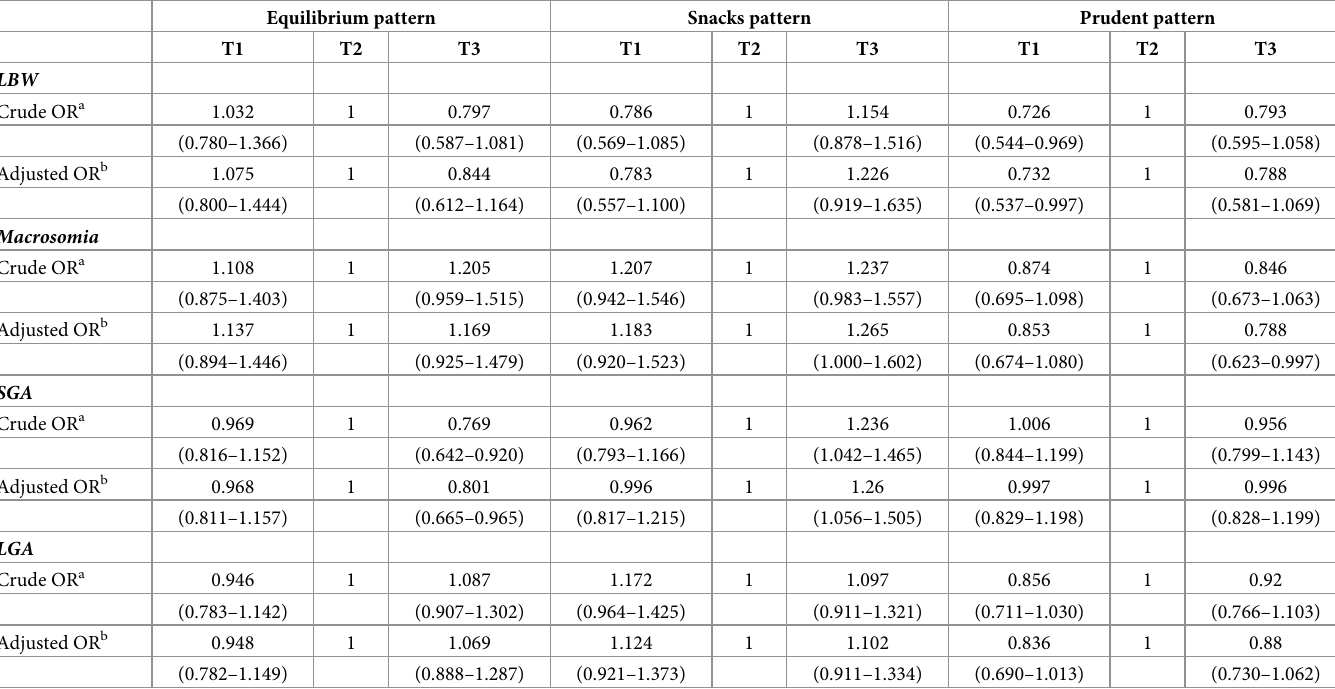
positively associated with LBW for 23.2% of participants (P < 0.05), with decreasing OR values from central Shaanxi to the north and south Shaanxi (Table 5 and S6 Fig). Similarly, infants born by women in the T3 group of snacks pattern was significantly correlated with macroso- (Table 5 and S7 Fig). Among about 80.0% of participants who lived in South and Central Shaanxi, there was a higher risk for SGA in the T3 group of snacks pattern than that in the T2 group (P < 0.05). The OR values tend to descend from South to North Shaanxi (Table 5 and Table 4. The association of diet pattern with abnormal birth outcomes using non-spatial logistical regression � . Equilibrium pattern Snacks pattern Prudent